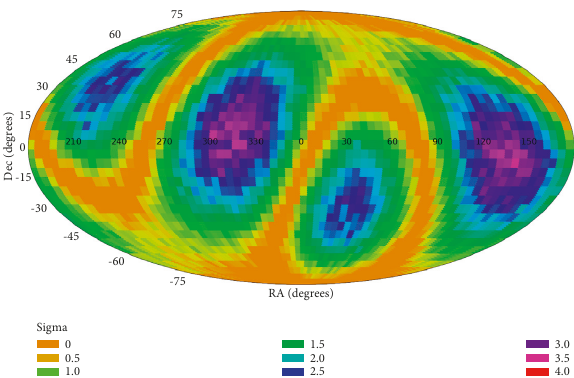
Figure 7: The probability of a quadrupole axis in the galaxy spin directions at different ( α , δ ) .